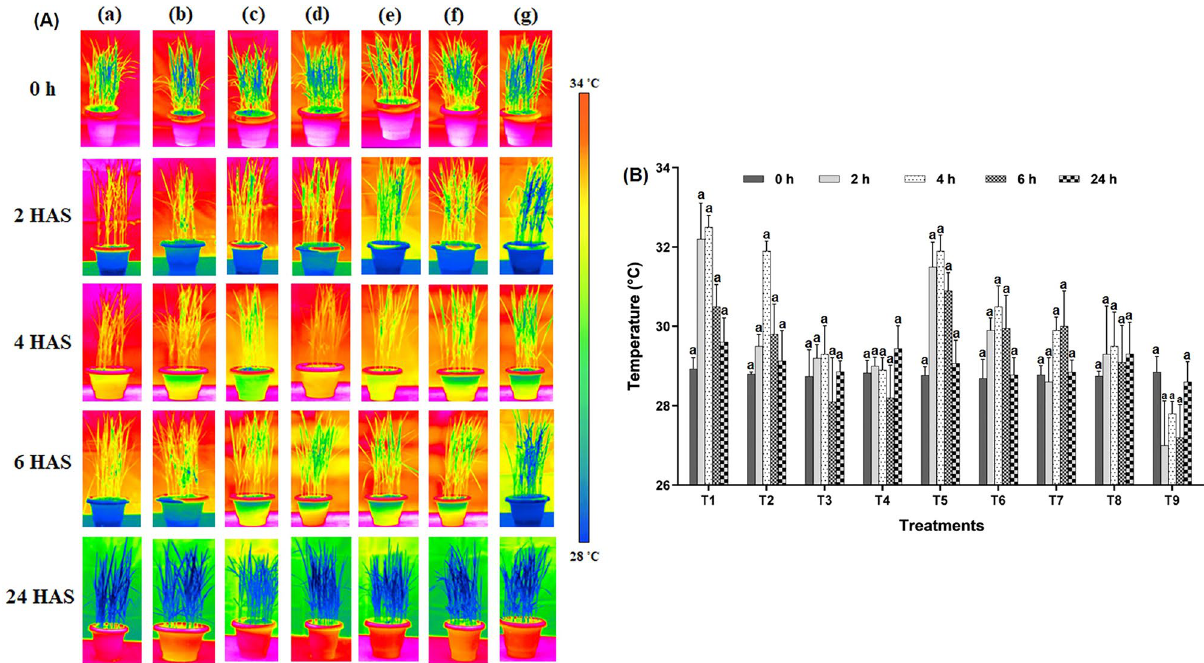
Figure 2. Influence of fungicidal stress on leaf temperature ( A ) Thermographic images of fungicide stressed and control rice plants with different treatments at 0, 2, 4, 6 and 24 HAS. Colour code of measured temperature is included (a) T 1 : tricyclazole, (b) T 2 : carbendazim, (c) T 5 : tricyclazole + LBS6, (d) T 6 : tricyclazole + LBD1, (e)